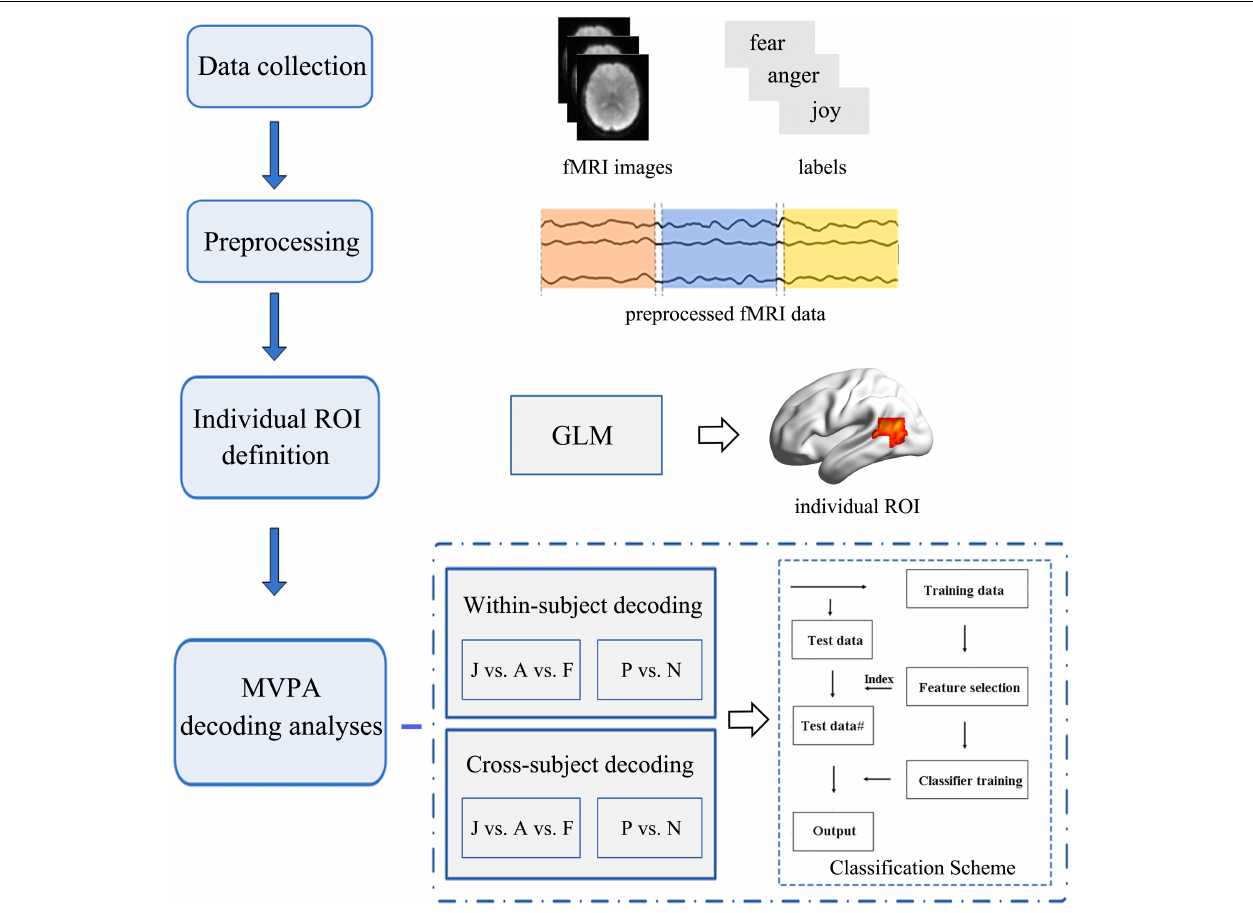
FIGURE 3 | Flowchart of the data analysis procedure. Multivariate pattern analysis (MVPA) emotion decoding analyses were conducted based on the individually defined regions of interest (ROIs). Two types of classification analyses (within-subject classification and cross-subject classification) were performed to examine the potential role of the motion-sensitive ROIs in the emotion decoding. Both three-way (joy vs. anger vs. fear: J vs. A vs. F) and two-way (positive vs. negative: P vs. N) emotion classifications were performed.